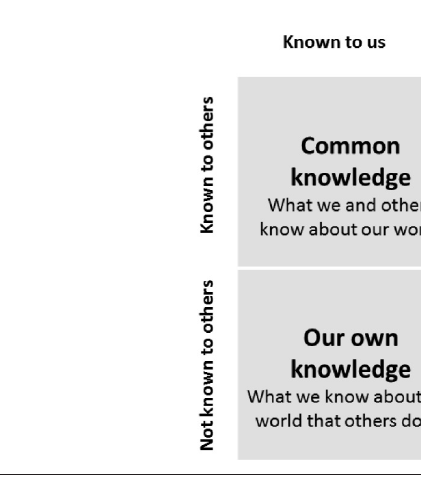
Figure 1: Familiar and unfamiliar